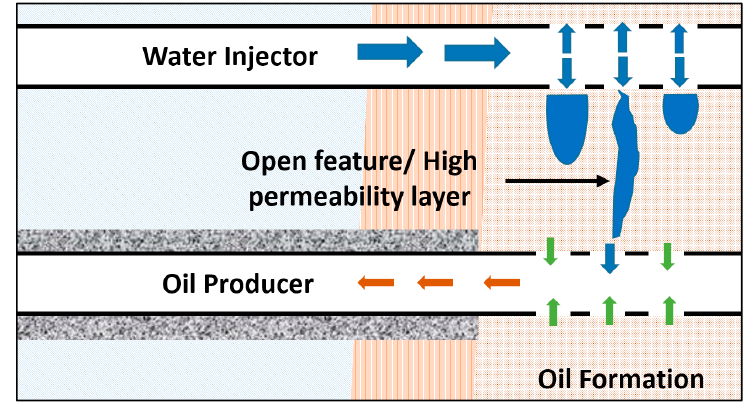
Figure 1. Example of a water injection well connected to an oil producer well through an open feature/high permebility layer.